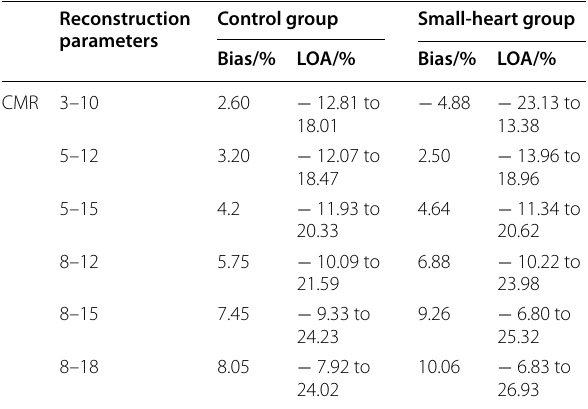
CMR cardiovascular magnetic resonance, LOA limits of agreement